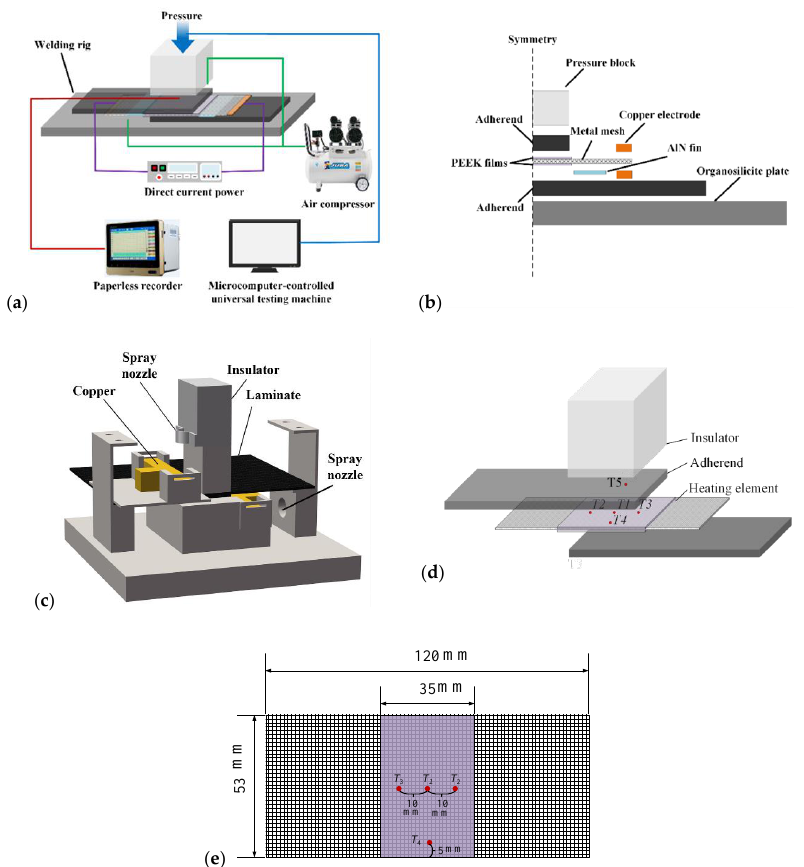
Figure 3. ( a ) Resistance welding system, setup ( b ) section schematic of adherent welding, ( c ) schematic of resistance welding assembly, ( d , e ) thermocouple positions. The resistance welding process began after electrical power was turned on and the subsequent application of constant external pressure and gas spraying. The displacement change along the thickness direction of the composite laminate monitored by the univer- sal testing machine is important for understanding the welding process and determining the welding termination and pressure relief points. A typical displacement curve of the lap joint during the welding process is shown in Figure 4. Four distinct stages can be iden- tified in the graph. Stage I is dominated by the volumetric expansion of the composite which led to close contact and an increase in the temperature in the welding joint. In stage II, macroscopic melting flow and squeezing occurred in the welding area and lasted until the power was turned off (welding termination point, t 2 ). There was also a decrease in the expansion rate. In stage III, the current was shut off, and the cooling process began. The melt continued to flow until the flow was arrested by the reduction of the transverse pres- sure or the viscosity increase and crystallization of PEEK. In stage IV, the displacement decreased to below zero. This was mainly caused by the thermal contraction of the lap joint. The pressure was released when the contraction stabilized (pressure relief point, t4),